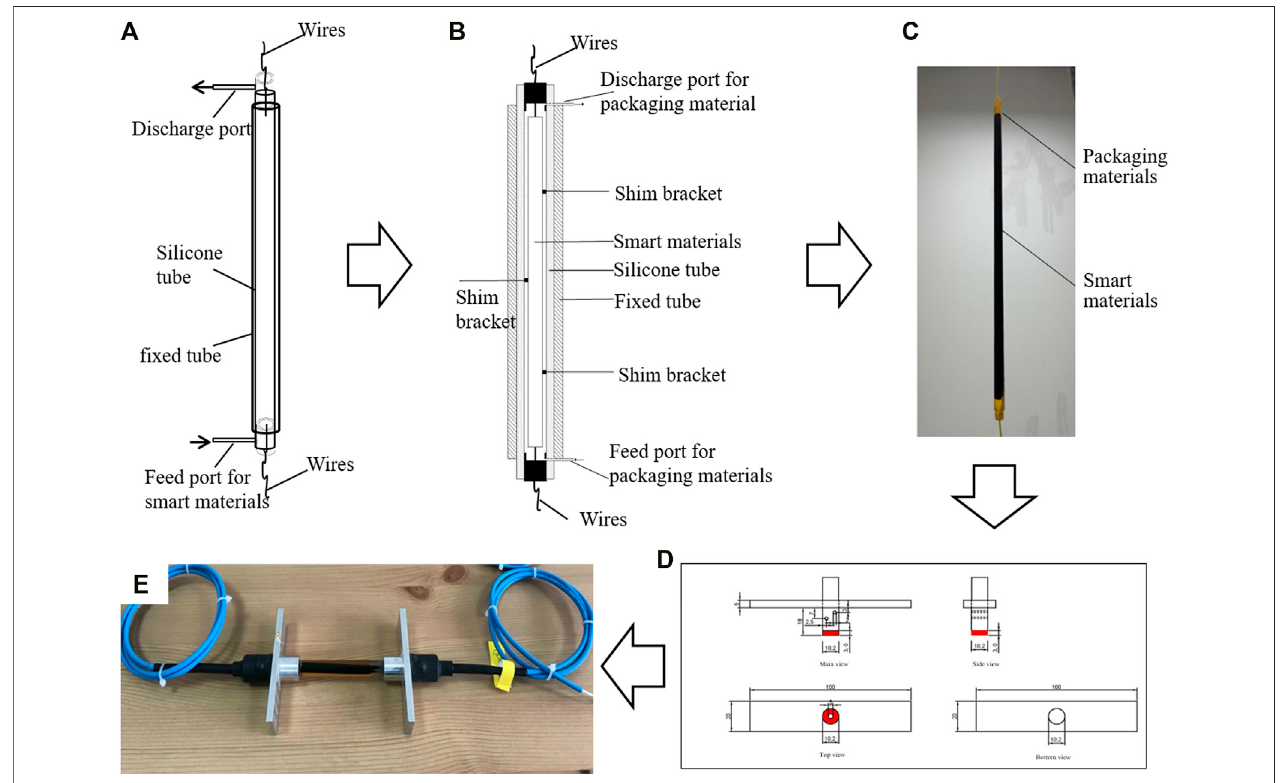
FIGURE 11 | The encapsulation and installation of sensor. (A) . Integrated forming mould of composites material with conductive electrode, (B) . Encapsulation mould of the sensor, (C) . The encapsulated sensor, (D) . Schematic diagram of I-beam design, (E) . schematic of the installed sensor.